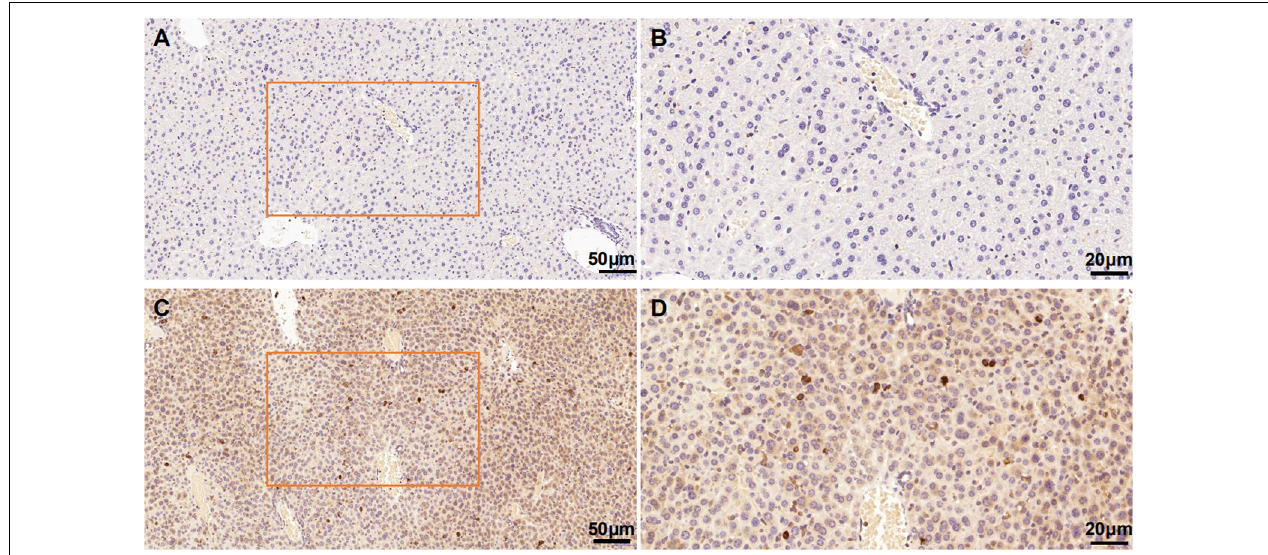
FIGURE 3 | Mesencephalic astrocyte-derived neurotrophic factor levels in the HKO control mice and WT control mice detected by immunohistochemistry with polyclonal antibodies. No positive staining was detected in the hepatocellular tissues of the HKO control mice (A,B) . MANF was detected in the hepatocellular tissues of the WT control mice (C,D) . Scale bar: 50 µ m (A,C) and 20 µ m (B,D)